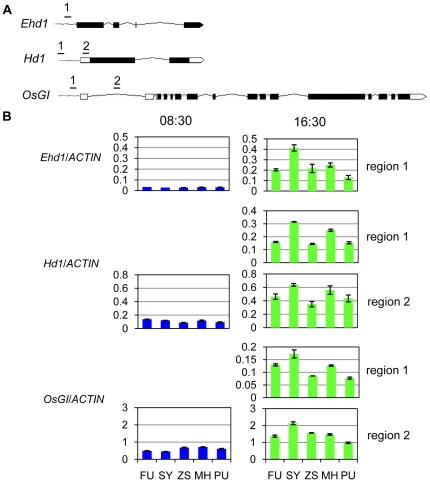
Histone H4 acetylation on flowering time genes.Chromatin isolated from 35 day-old rice leaves of SY63 (SY), MH63 (MH), ZS97 (ZS) and OsHDT1 over-expression in SY63 (FU) and MH63 (PU) background, harvested at 8:30 and at 16:30 (of the subjective day) under long day conditions were precipitated by antibody of acetylated histone H4. The precipitated DNA was analyzed by real-time PCR using the primer sets corresponding to the 5′ region of the genes (A). The 5′ region of rice actin gene was amplified as internal control. One region for each gene was analyzed at 8:30 and two regions of Hd1 and OsGI were analyzed at 16:30. Values relative to actin gene are shown (B). Error bars, s.e.m. from 3 biological repeats.